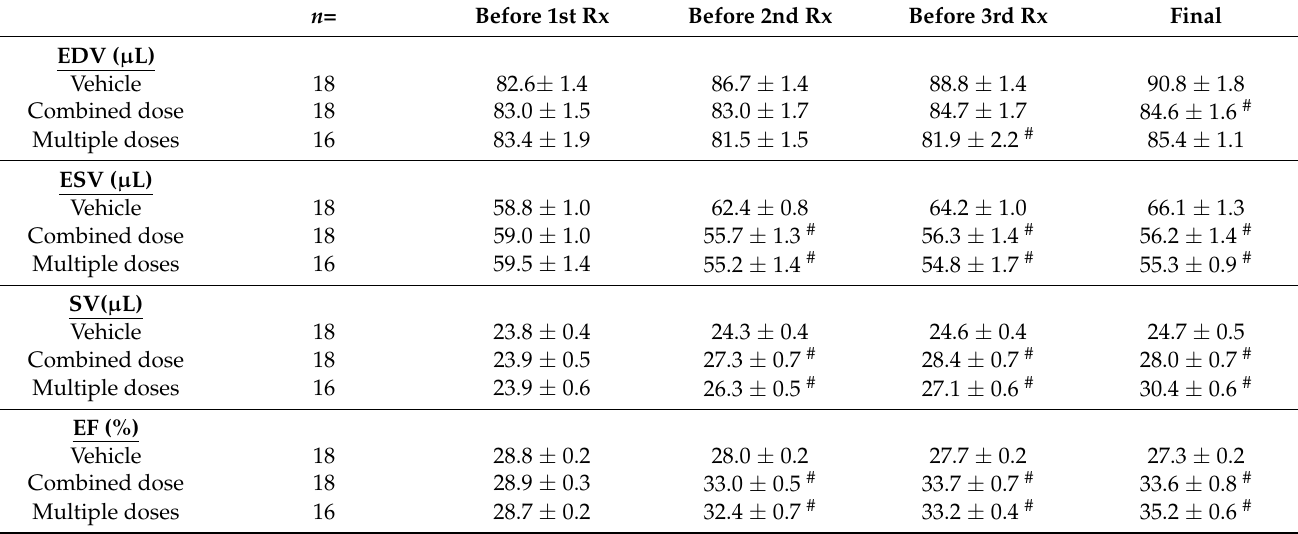
Table 1. Echocardiographic Results.